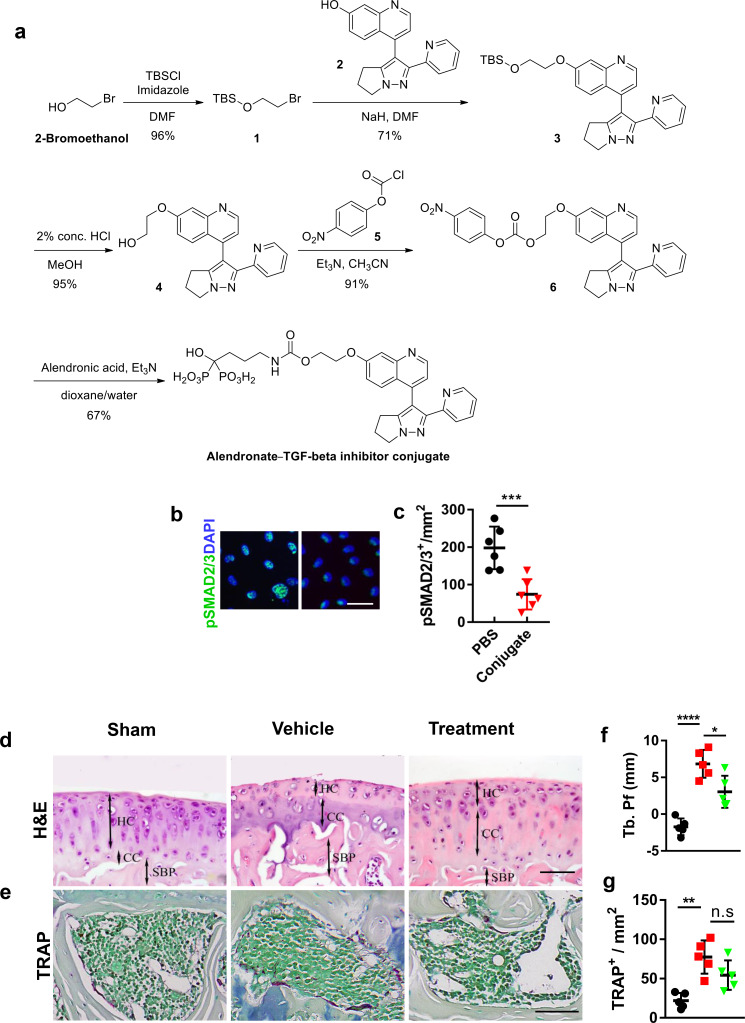
Alendronate-TβR1I inhibitor conjugate attenuates aberrant subchondral bone remodeling after ACLT.(a) De novo synthesis of Alendronate-TβR1I inhibitor conjugate. (b, c) Representative photos (b) and statistical analysis (c) of pSMAD signal in immunostaining of human MSCs, 20 μm. (d, e) Representative photos of knee joint H and E (d) and TRAP (e) staining in mice 4 weeks after sham or ACLT or surgery or treatment at 1 m. Scale bars, 50 μm (b), 20 μm (c). (f, g) Statistical analysis of Tb. Pf (f) and TRAP+ cells (g) in WT mice 4 weeks after sham or ACLT surgery or treatment at 1 m. n = 6 per group. *p<0.01, ***p<0.001, ****p<0.0001 compared with the sham-operated group or healthy donors at different time points. Statistical significance was determined by multifactorial ANOVA WITH BONFERRONI POST HOC TEST (f, g), unpaired Student’s t test (c) and all data are shown as scattered plots with means ± standard deviations.